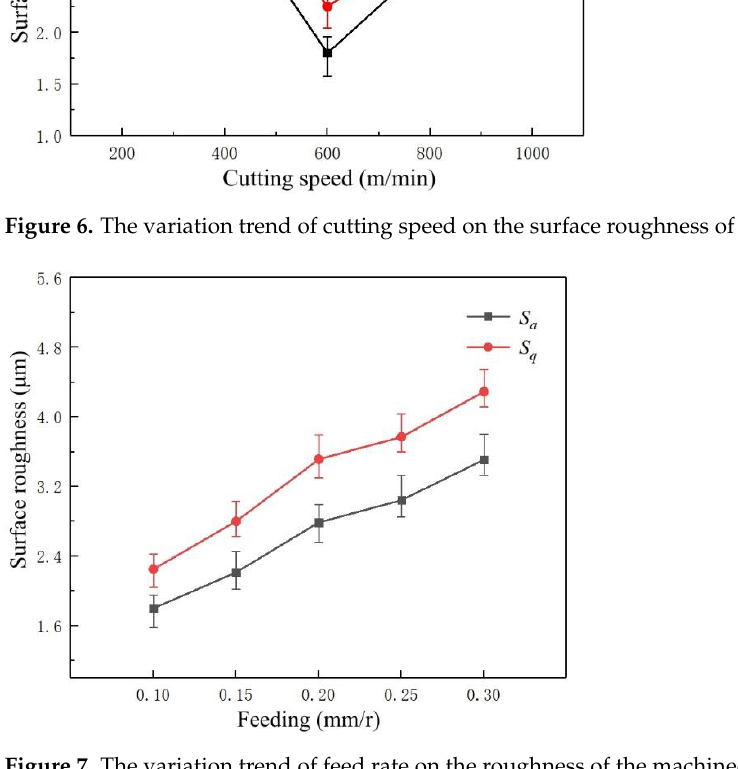
Figure 7. The variation trend of feed rate on the roughness of the machined surfaces.